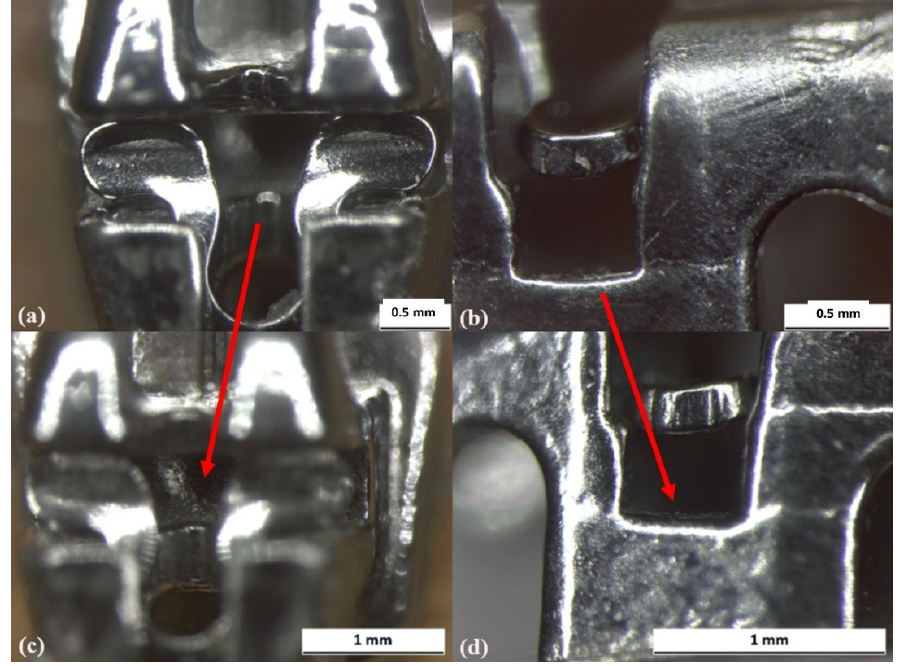
Figure 6. Mistral Plus bracket (Micerium Orthodontics) in top and side view: ( a , b ) before the test; ( c , d ) after the test.